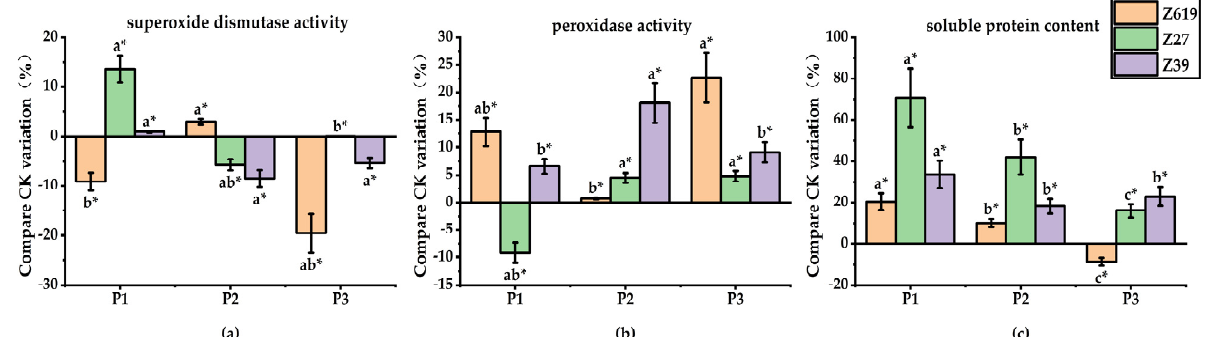
Figure 6. ( a ) Effects of different concentrations of paclobutrazol on superoxide dismutase activity in root system; ( b ) Effects of different concentrations of paclobutrazol on peroxidase activity in roots; ( c ) Effect of different concentrations of paclobutrazol on soluble protein content in roots. * Different lowercase letters in the figure indicate that different treatments of the same variety have significant differences at p < 0.05.